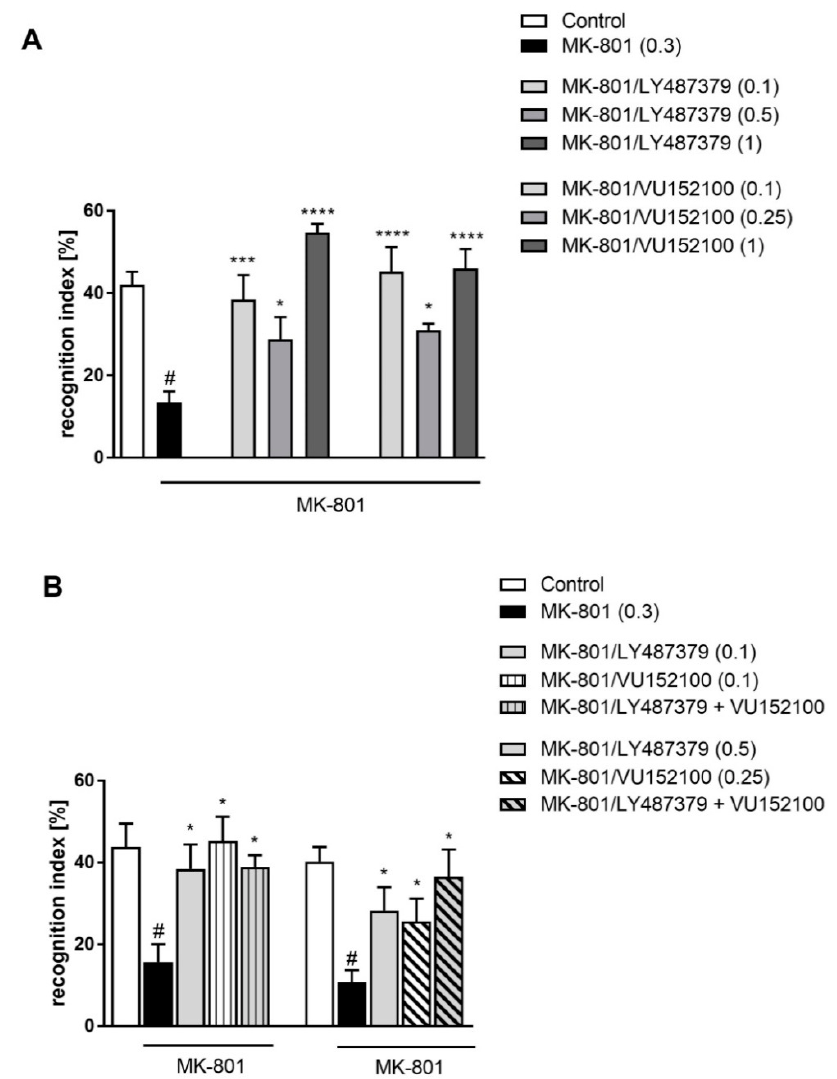
Figure 4. Novel object recognition test in mice after chronic administration (7 days) of MK-801. Effectivity of LY487379 and VU152100 administered alone ( A ), and combined administration of low doses of LY487379 and VU152100 ( B ). Compounds were administered acutely 30 min before the test. Investigated doses are indicated in parentheses. Bars represent the means ± SEM. N = 8–10/group. # p < 0.001 versus the control group; * p < 0.05 and *** p < 0.001 and **** p < 0.0001 versus the MK-801-treated group.